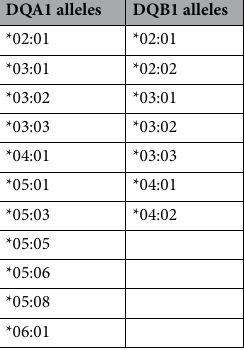
Table 2. DQA1 and DQB1 alleles used for analysis with NetMHCIIpan 3.2. The HLA alleles listed are those that have been confirmed in the Japanese population.